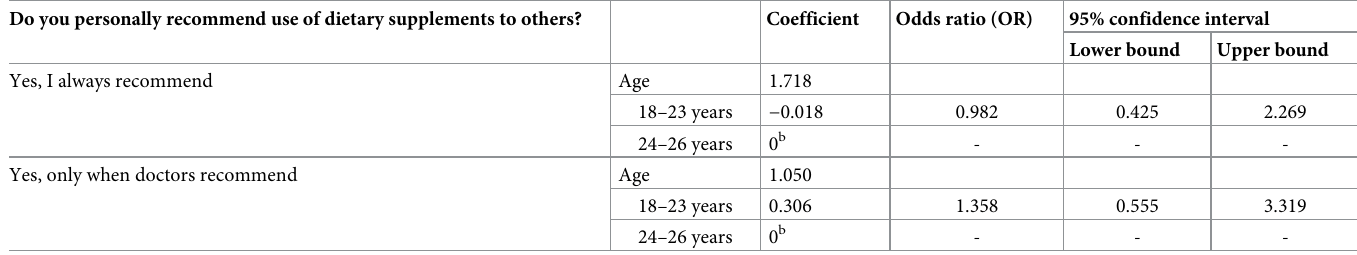
Table 12. Multinomial logistic regression analysis. Do you personally recommend use of dietary supplements to